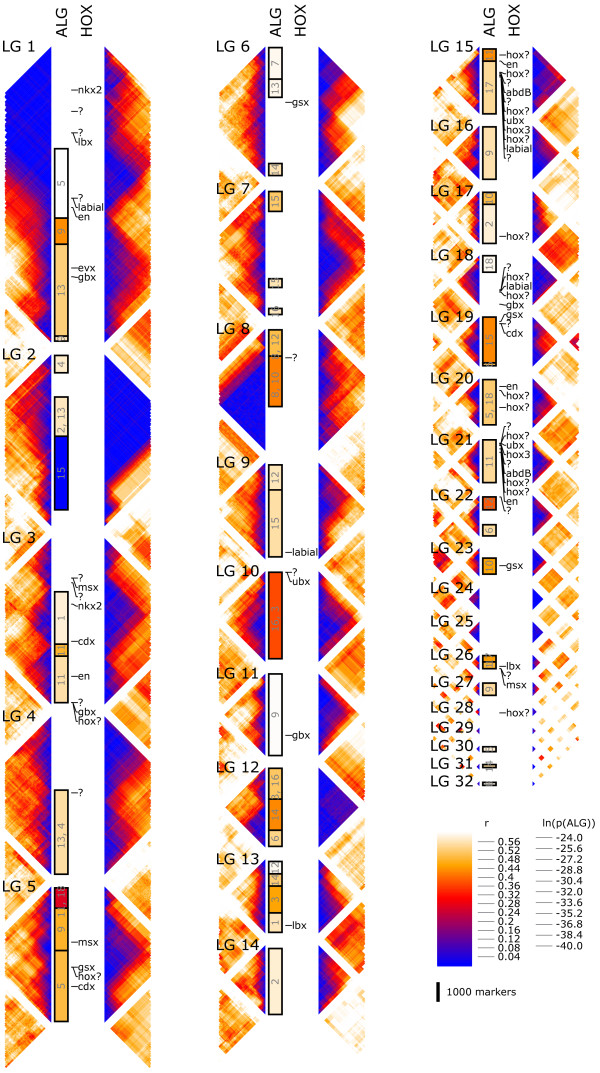
Each of the numbered blocks represents one of the 32 linkage groups of the L. polyphemus genetic map, and is composed of four columns: Two bands of the triangular matrices in which the color scale indicates the fraction of samples showing recombination between pairs of markers; maternal recombination frequency is shown on the left, paternal on the right. A column labeled “ALG” indicates segments of significant (p  < 0.05 in Fisher’s Exact Test, after Bonferroni correction for multiple tests) conservation of gene content with ancestral bilaterian linage groups. The column labeled HOX shows the map positions and types of predicted homeobox transcription factor genes. The two color scales are for: recombination frequency between pairs of markers and log p-value for enrichment in gene content with ancestral linkage groups.